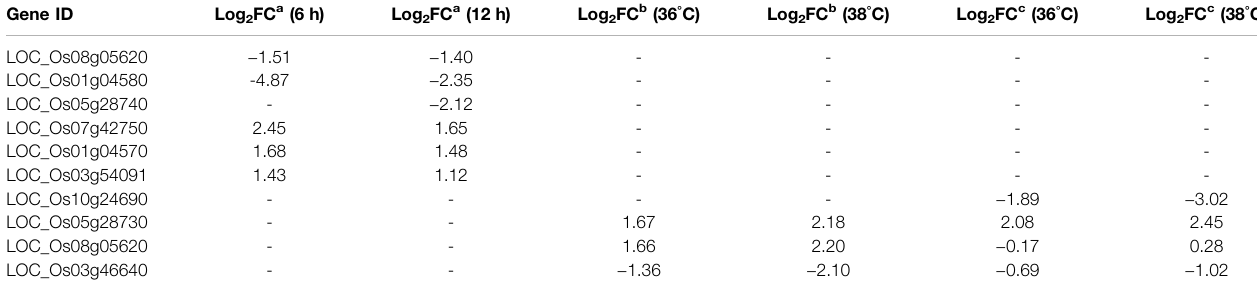
TABLE 4 | Differential expression of some putative candidate genes identi fi ed in the present study from published datasets. Gene ID